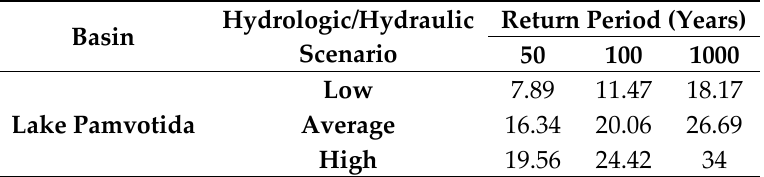
Figure 3. Flood extent and maximum water depths of return period T = 1000 years for all examined scenarios ( a ) and simulated maximum velocities ( b ) only for the average scenario. Table 1. Total inundated area (km 2 ) of Lake Pamvotida basin for all examined hydrologic and hydraulic scenarios at the selected return